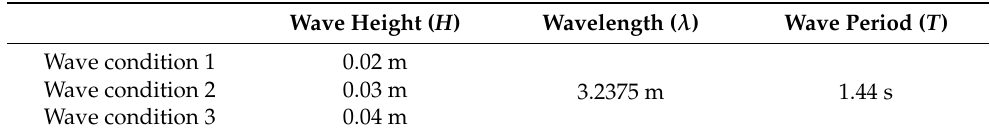
Figure 5. Typical surface meshes and focal point of a bull’s -eye waves simulation.